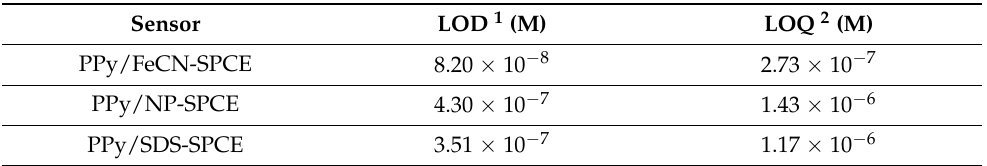
Table 5. Data achieved from the calibrations curves for PPy/FeCN, PPy/NP, and PPy/SDS sensors at Tyr detection.